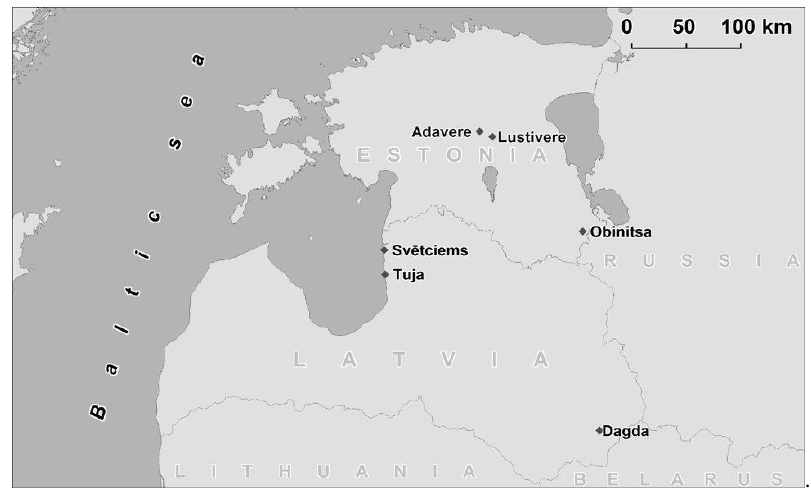
Figure 1. Location of the study areas.